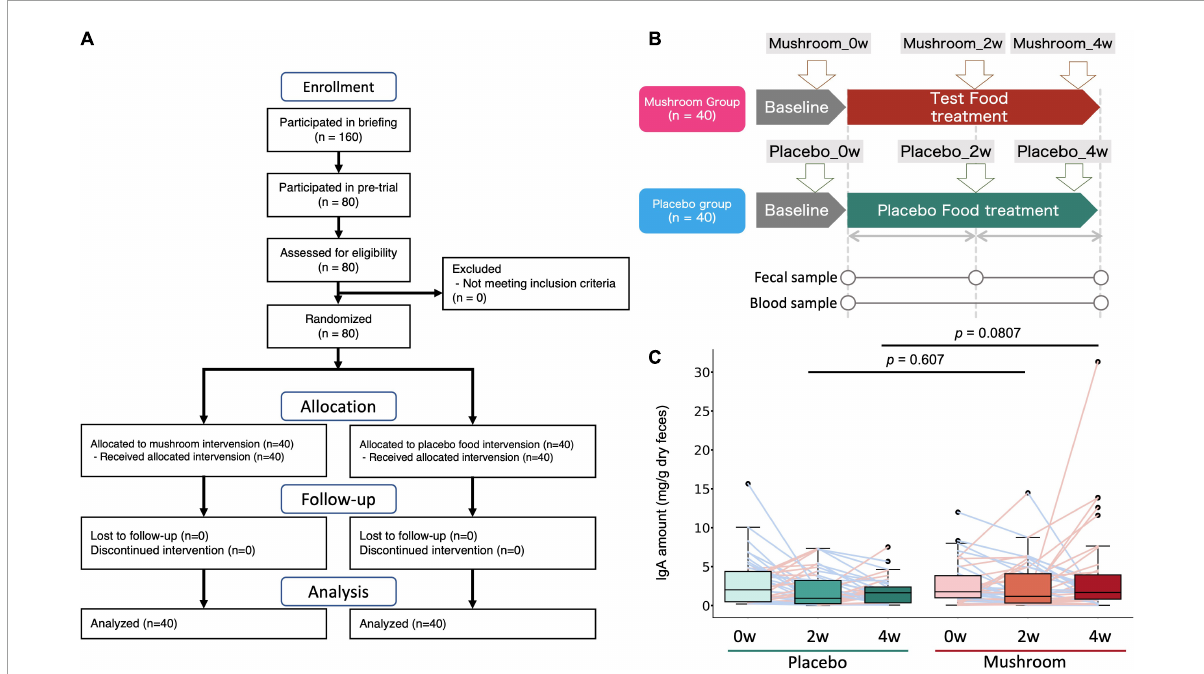
FIGURE1 Clinical trial overview and test results for the primary endpoint (intestinal IgA content). (A) Flow diagram of the trial. (B) Clinical trial diagram and description of time points. Subjects were assigned to either the test food (mushroom) group or the placebo food group, and they consumed the assigned food for 4 weeks. (C) Distribution of the primary outcome (intestinal IgA content). The difference between each time point and baseline was calculated and expressed by group and time point. The Wilcoxon rank sum test was performed for comparisons between groups at each intake period (2 or 4